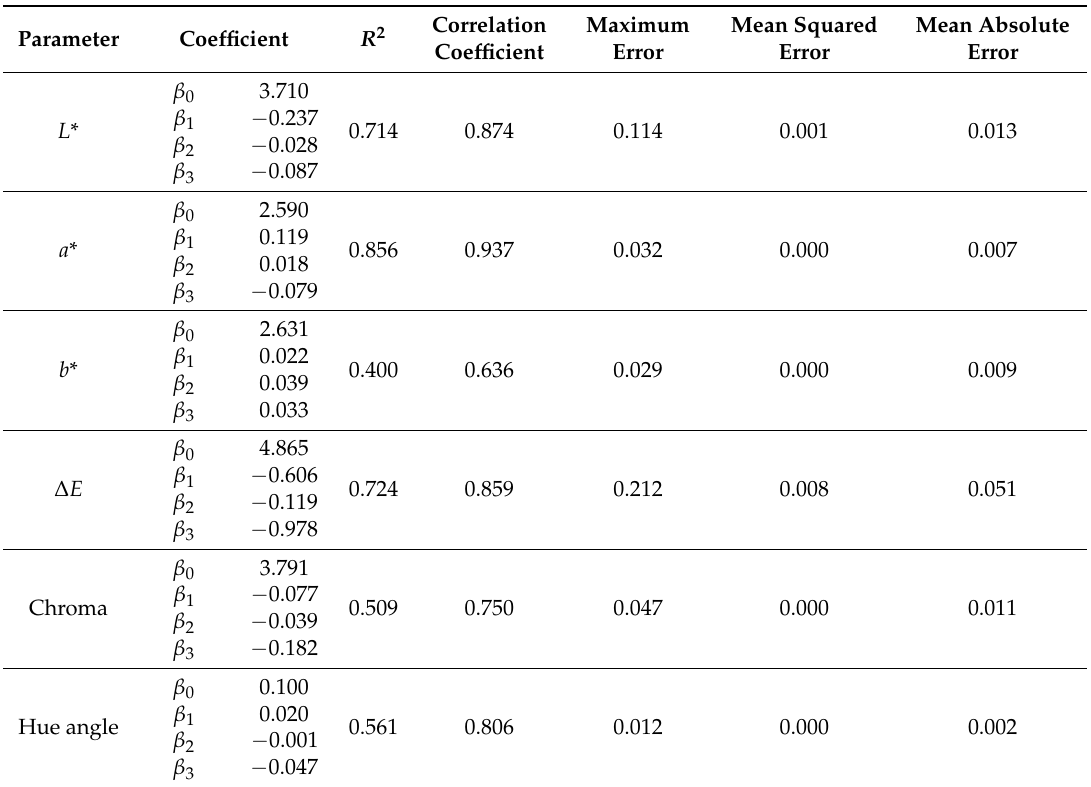
Table 6. Linear regression models coefficients for description of colour components change